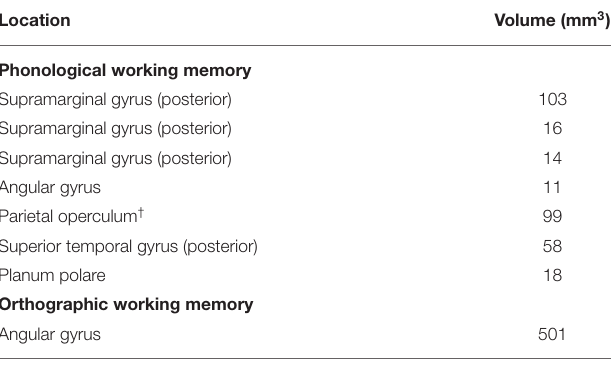
TABLE 4 | Left hemisphere SVR-LSM results: clusters of significant voxels that surpass the most stringent voxel thresholding based on a distribution of maximum beta values obtained from analyses of 5,000 random permutations of the data